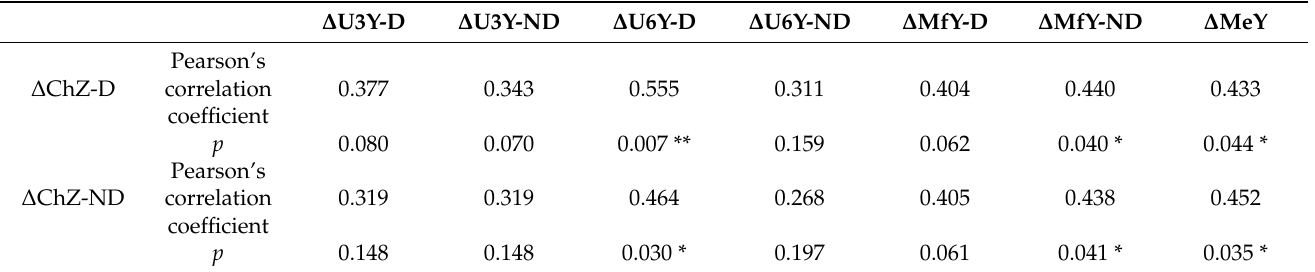
Table 6. Correlation between the vertical changes in the cheilions ( ∆ ChZ-D/ND) and the changes in other variables in the anteroposterior